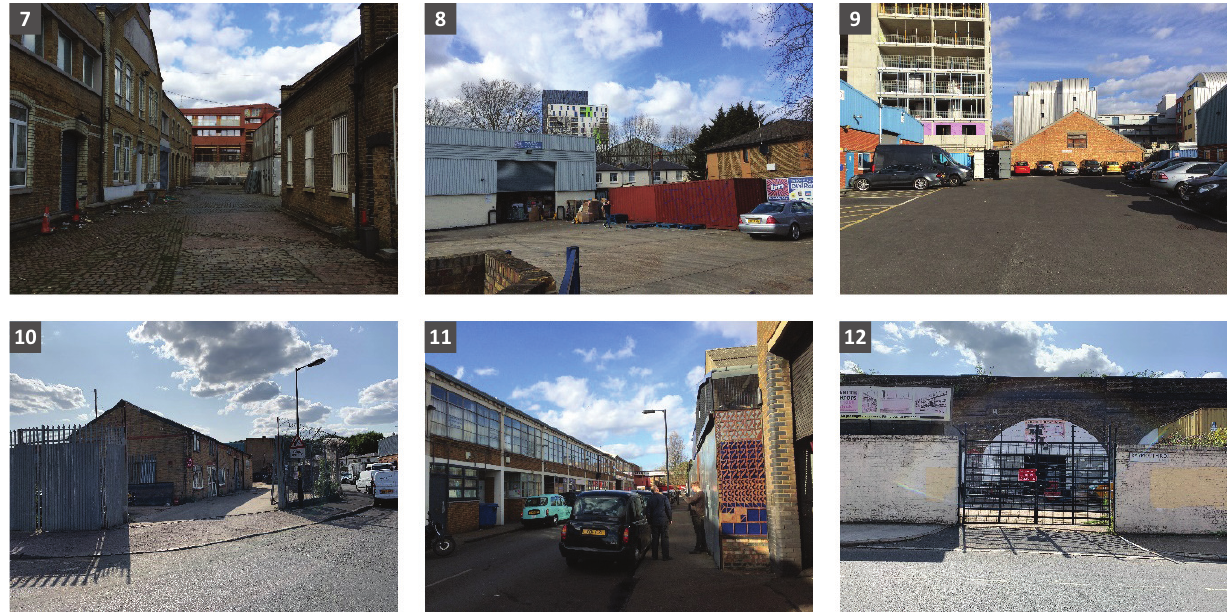
Figure 6. Present‐day photographs of Old Kent Road. Source: Photographs taken by the authors during weekday site visits in working hours on 12 July 2019, 20 August 2019, and 9 October 2019.